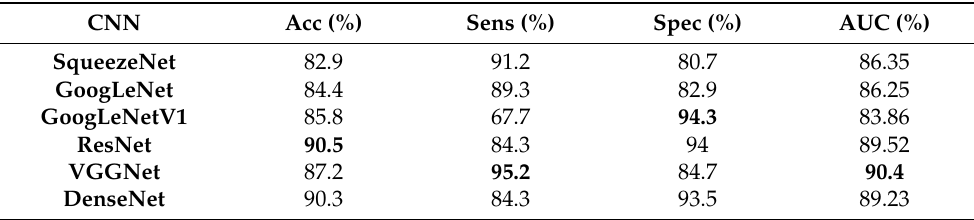
Table 2. The values of the performance parameters obtained when providing the B-mode ultrasound images at the CNN